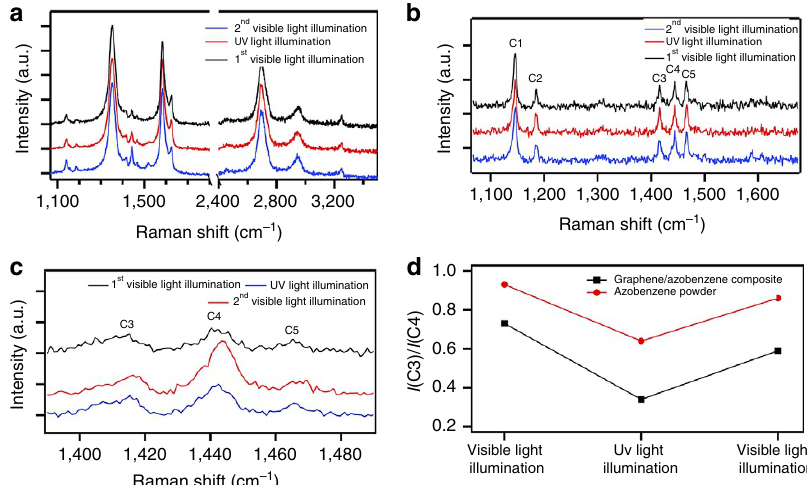
Figure 4 | Evolution of Raman spectra on illumination. ( a ) Comparison of the Raman spectrum of a graphene/4-(decyloxy) azobenzene hybrid film after 90-min illumination with visible light, UV light and visible light again to probe the effect of isomerization. ( b ) The same experiment on azobenzene powder. ( c ) 4-(decyloxy)azobenzene Raman peaks C3, C4 and C5 extracted from graphs in a showing the change of peaks ratio on illumination, which confirms the isomerization. ( d ) Dependence upon illumination of I (C3)/ I (C4) for both hybrid material and